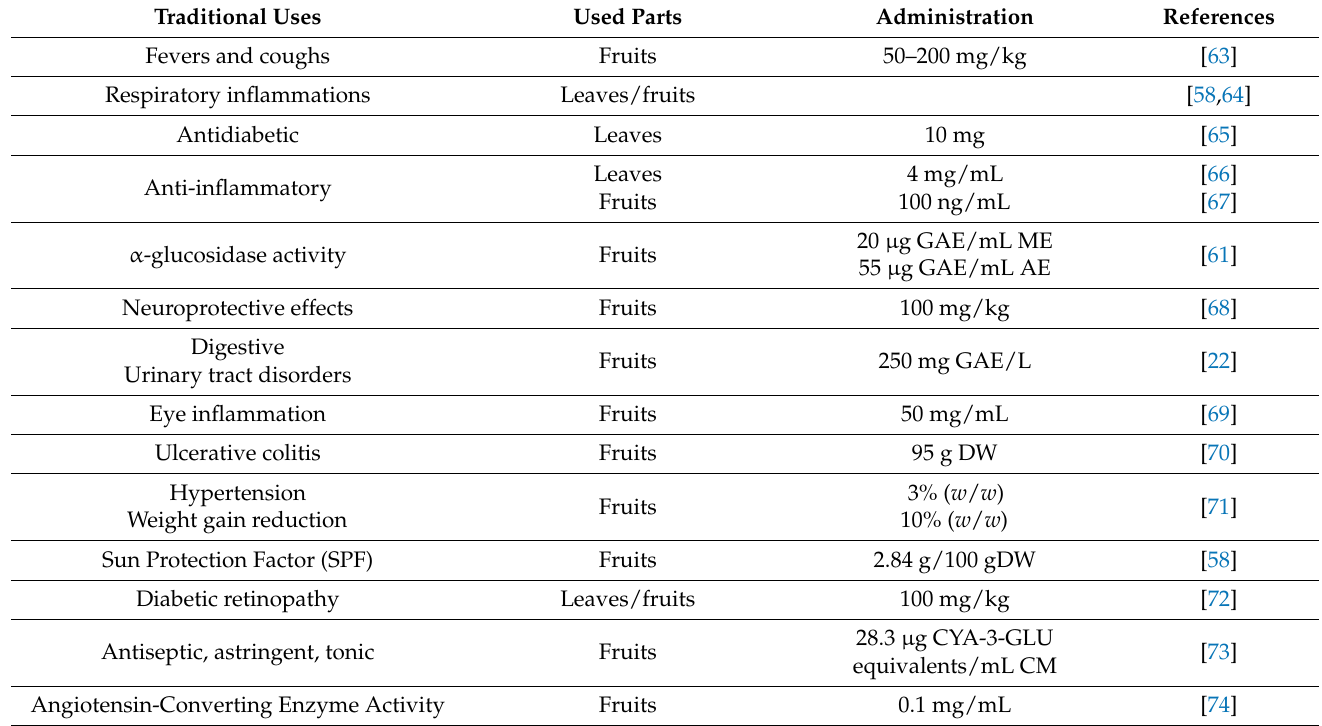
Table 2. Traditional uses of V. myrtillus